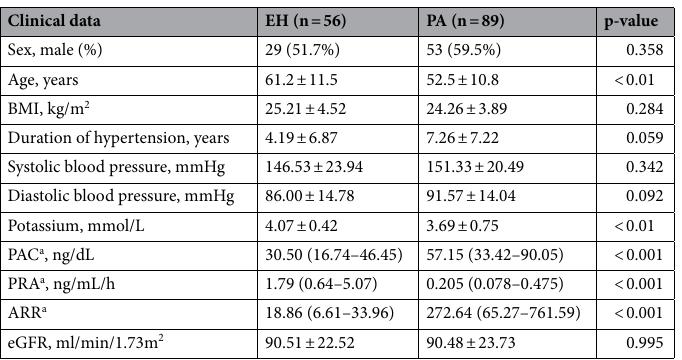
Table 1. The clinical characteristics of the patients. Data were presented as the mean ± SD, median (interquartile range) or number (%). PAC plasma aldosterone concentration, PRA plasma renin activity, ARR aldosterone to renin ratio. a Expressed as median and interquartile